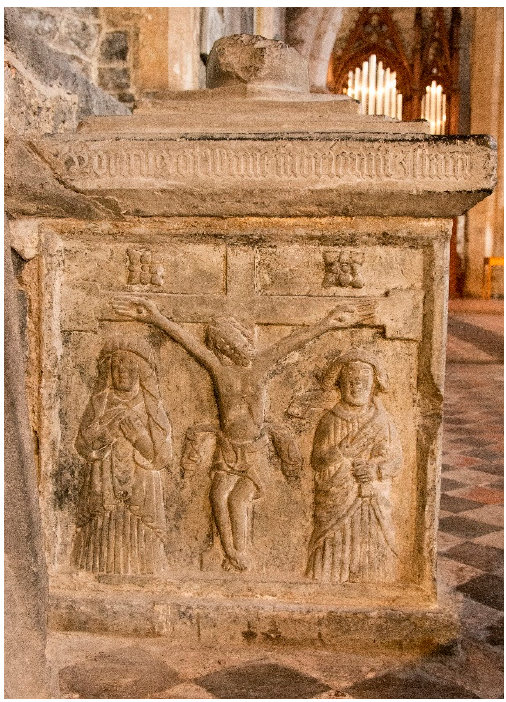
Figure 27. Tomb of John Grace, St. Canice’s Cathedral, Co. Kilkenny, c.1552. Photograph by the